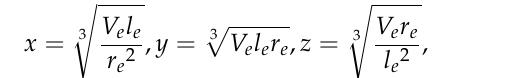
Figure 2. Multiscale data augmentation. Red box represents the region of an HSI sample.